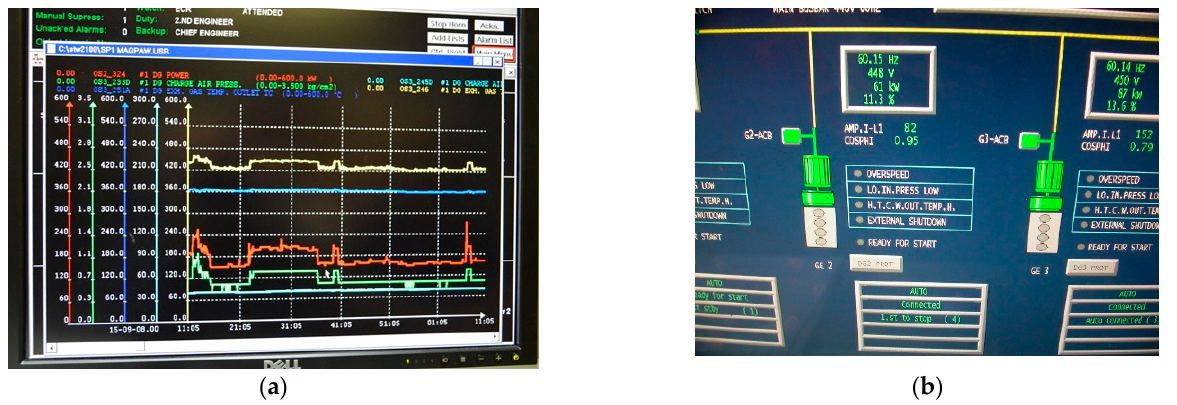
Figure 6. Recorded loads of a generating set ( a ) and operation of two generating sets at a load of 11.3% and 13.6% in transient states ( b ): DG —active power of the generating set in kW.